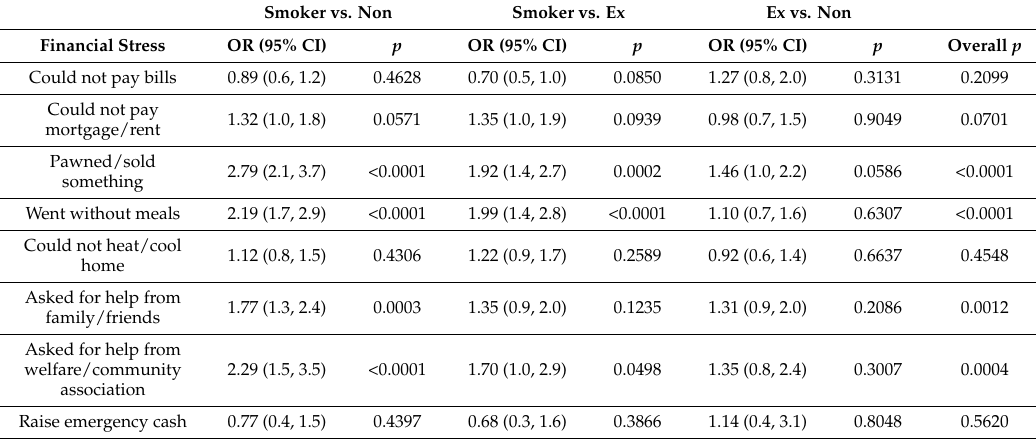
Table 3. Adjusted 1 comparison of financial stress individual indicators for non-, ex-, and current